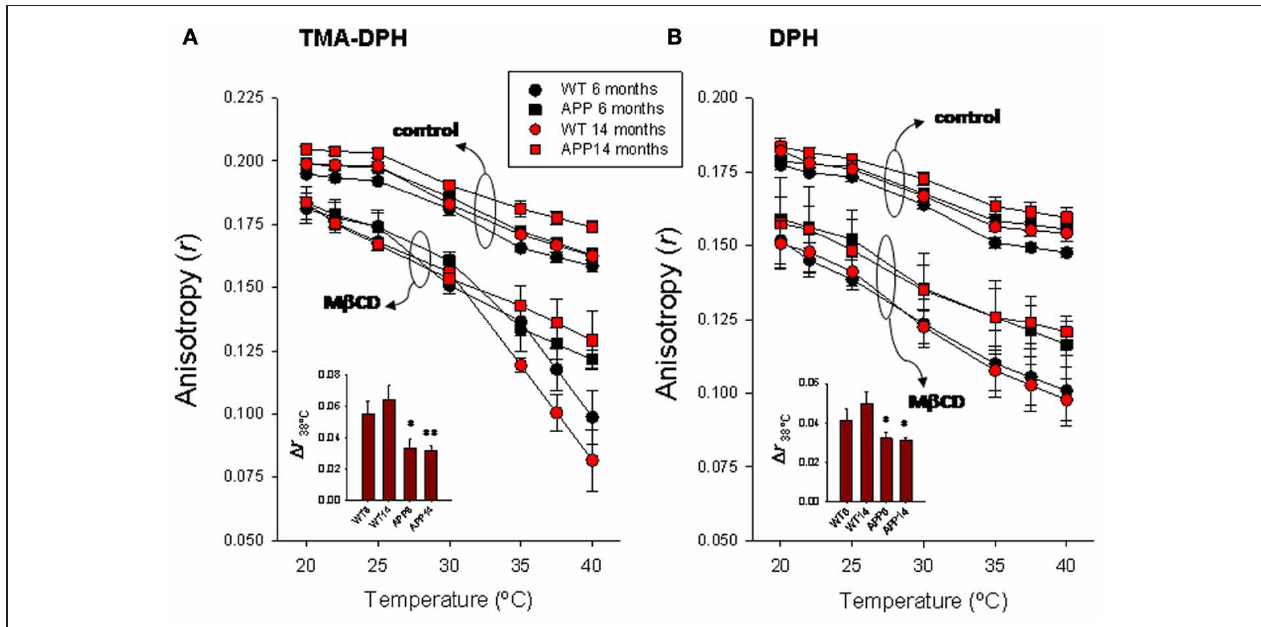
FIGURE 2 | Temperature-dependence of steady-state fluorescence anisotropy for TMA-DPH (A) and DPH (B) in frontal cortex lipid rafts. Lipid rafts were isolated from WT and APP/PS1 animals aged up to 6 and 14